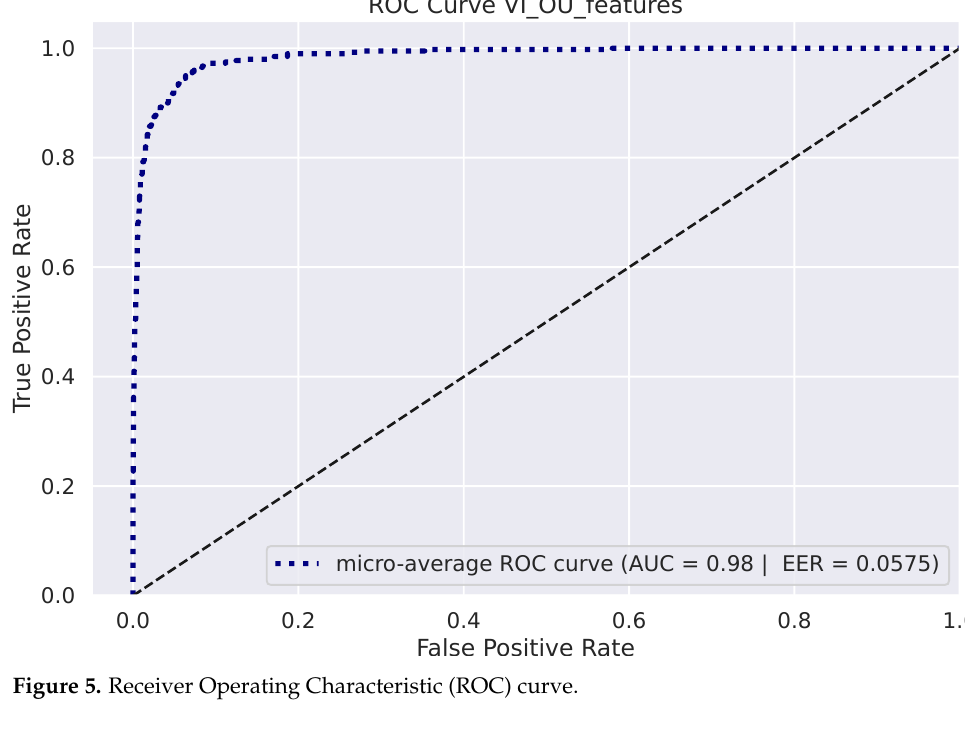
Figure 5. Receiver Operating Characteristic (ROC) curve.